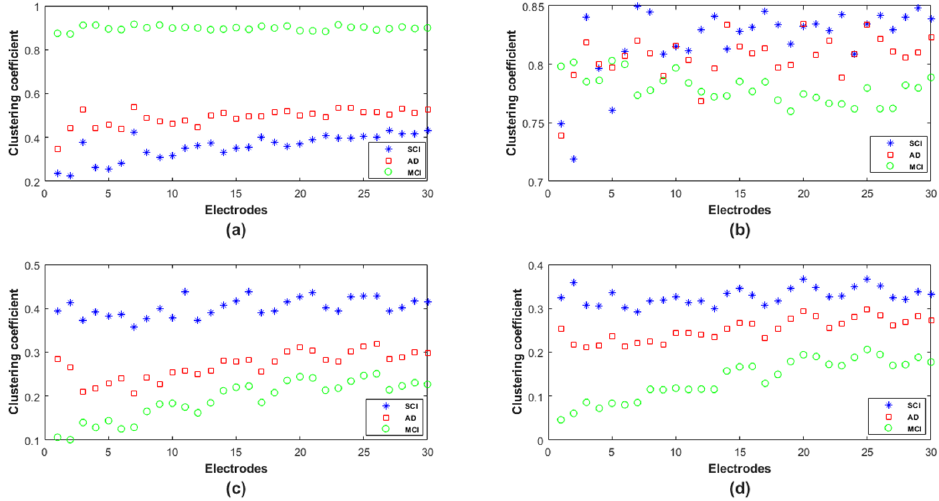
Figure 10. Clustering coefficient values over the 30 electrodes for SCI, MCI and AD on the ( a ) delta, ( b ) theta, ( c ) alpha and ( d ) beta bands.